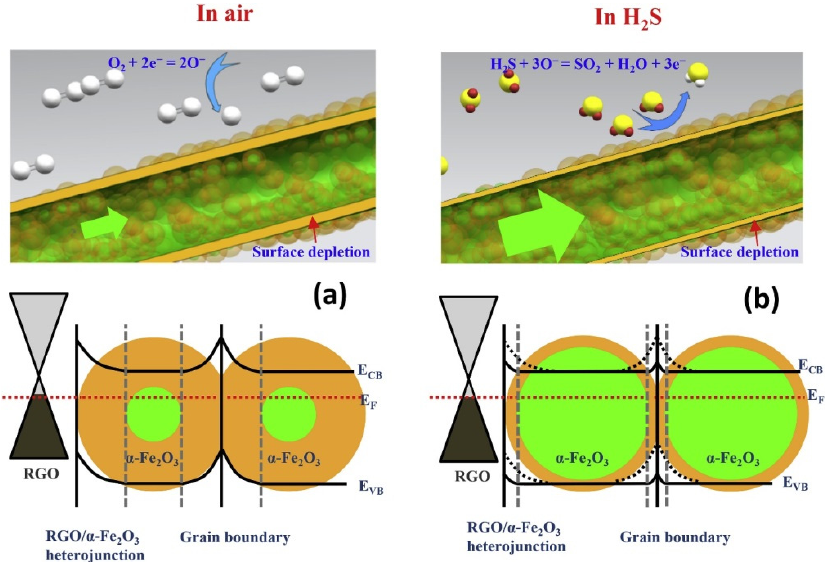
Figure 14. Schematic diagram of H 2 S sensing mechanisms of α -Fe 2 O 3 NFs and rGO-loaded Fe 2 O 3 NFs in ( a ) air and in ( b ) H 2 S gas [70].